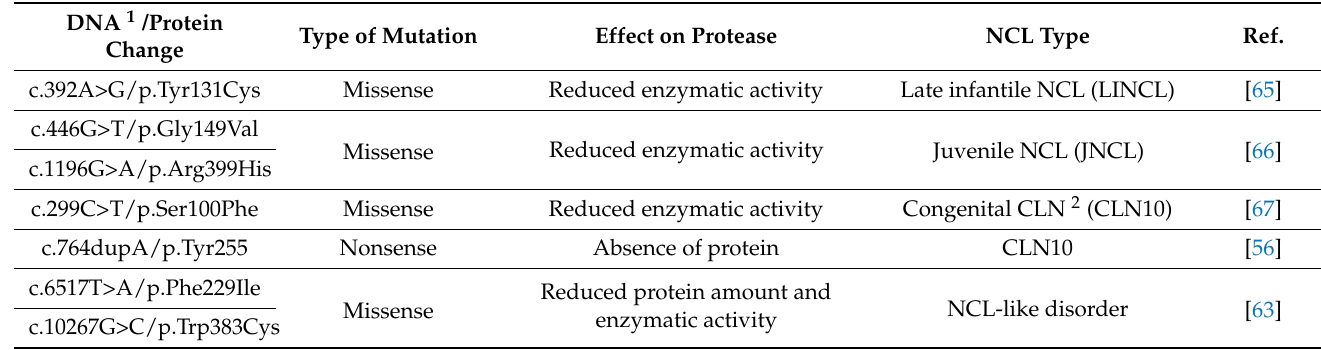
Table 1. Cathepsin D mutations related to neuronal ceroid lipofuscinosis (NCL). DNA 1